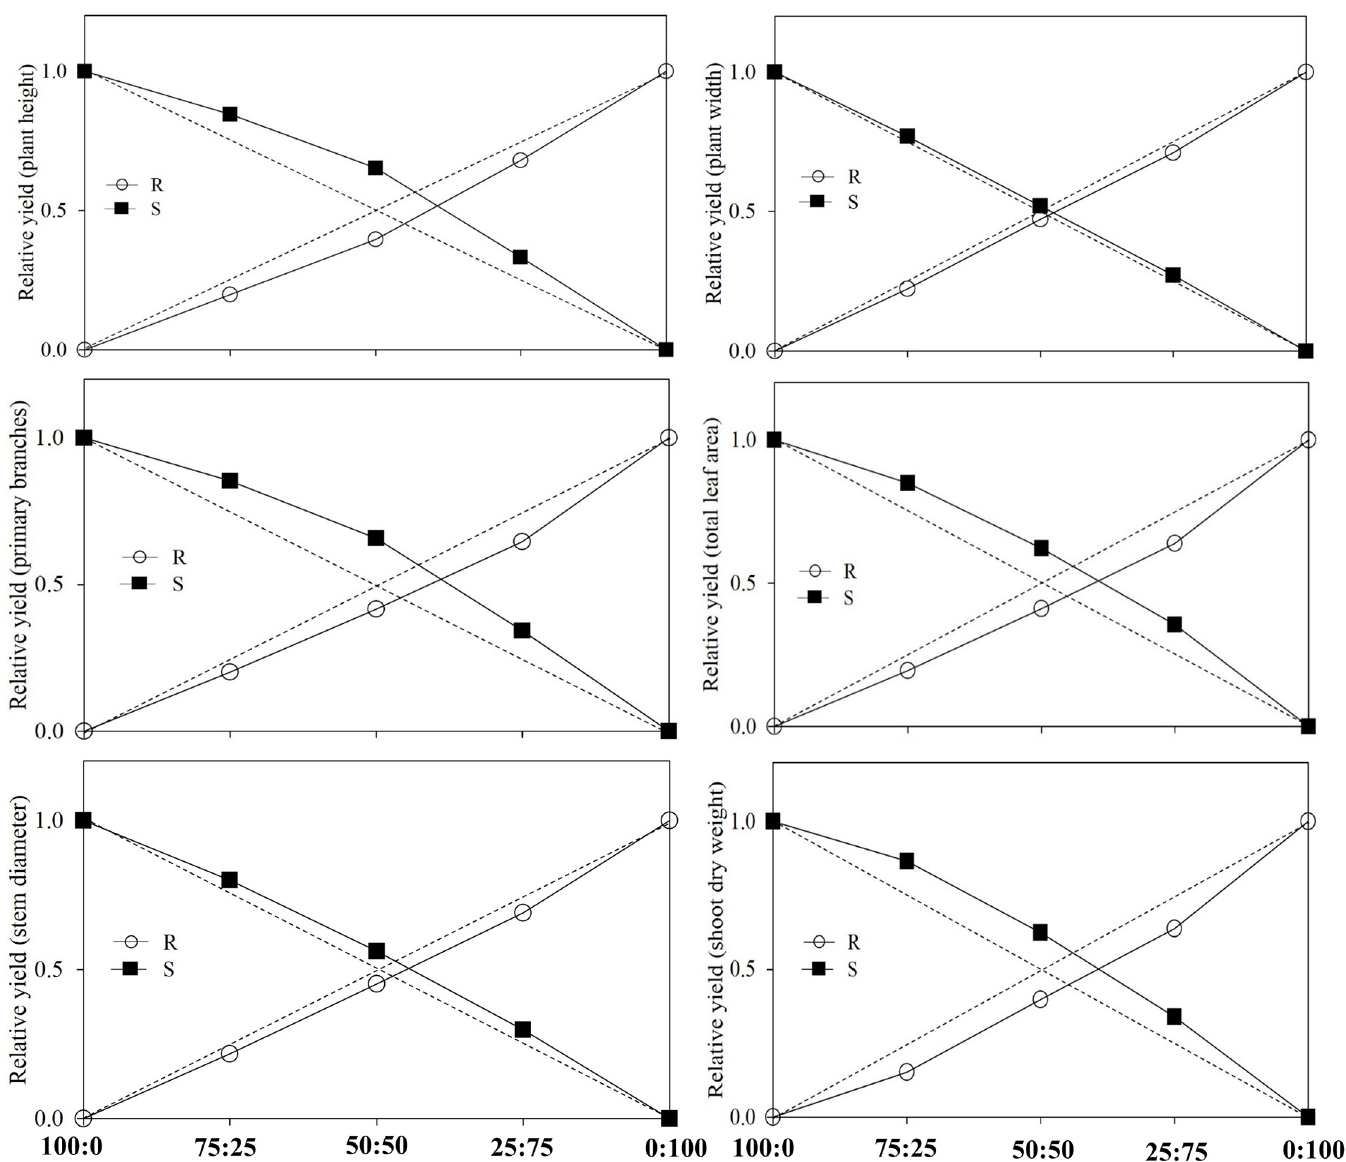
Fig 2. Estimated relative yield (RY) for vegetative growth parameters under different mixture proportions of dicamba-fluroxypyr – susceptible (S) and – resistant (R) K . scoparia in the replacement series experiments averaged over experimental runs. Dashed lines indicate the expected hypothetical values (H 0 ) for RY when the two selected lines are equally